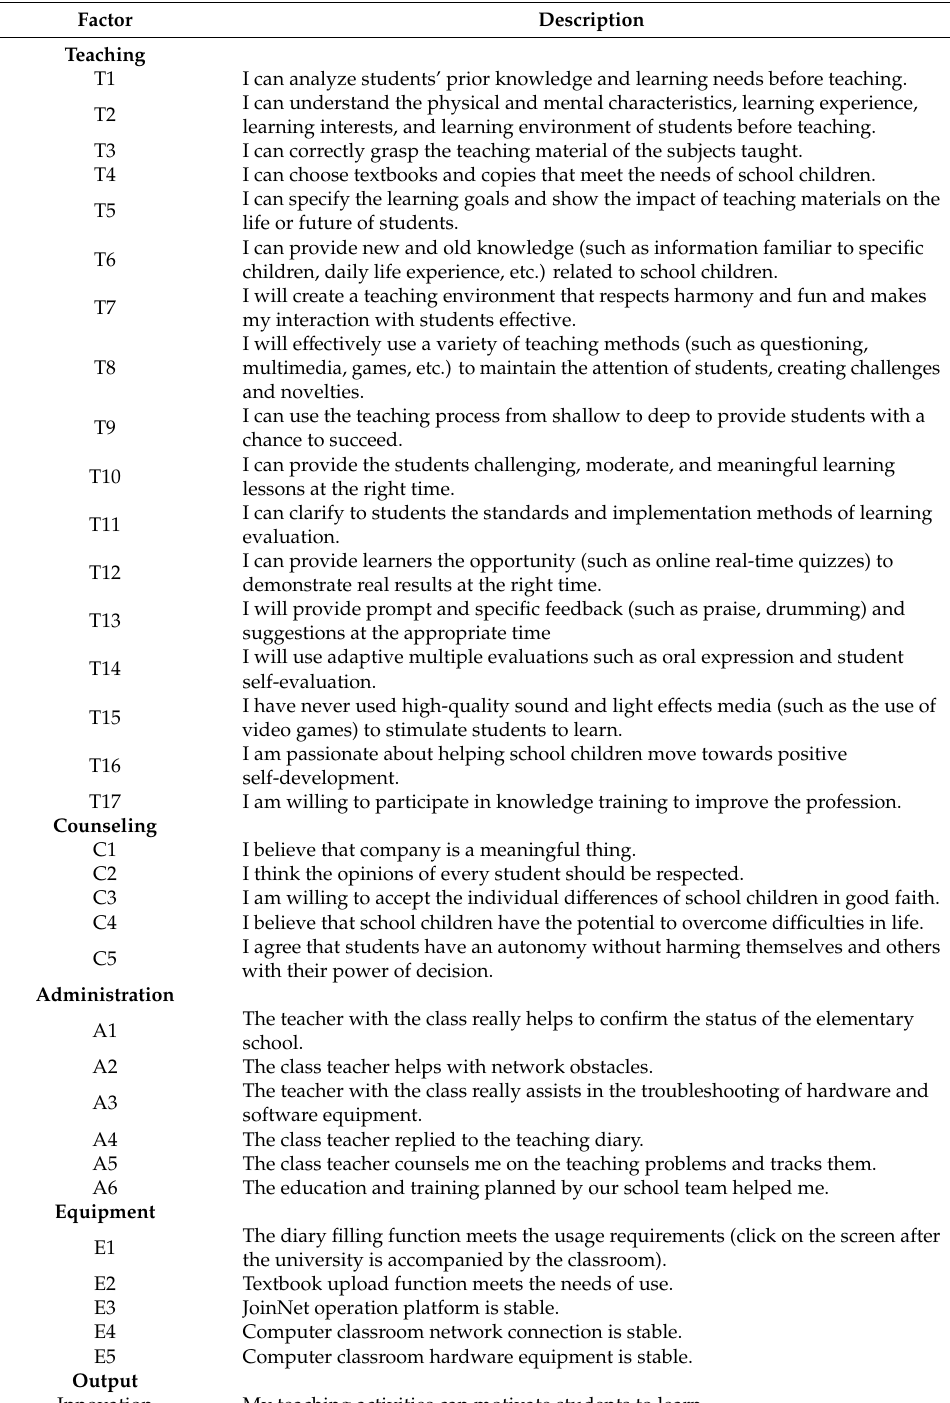
Table 1. Questionnaire